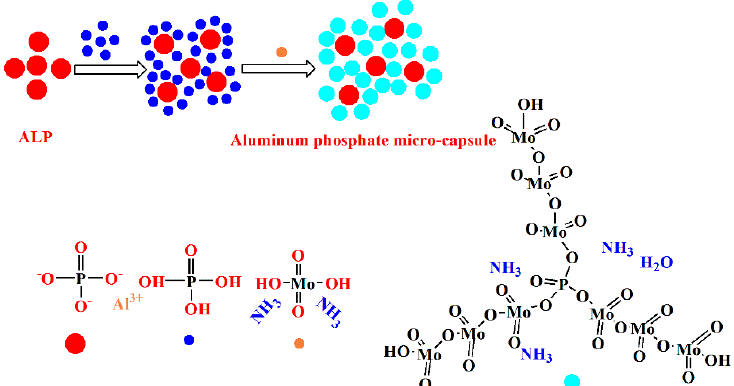
Figure 1. The synthesis route of an aluminum phosphate micro-capsule. ALP—aluminium phosphate.